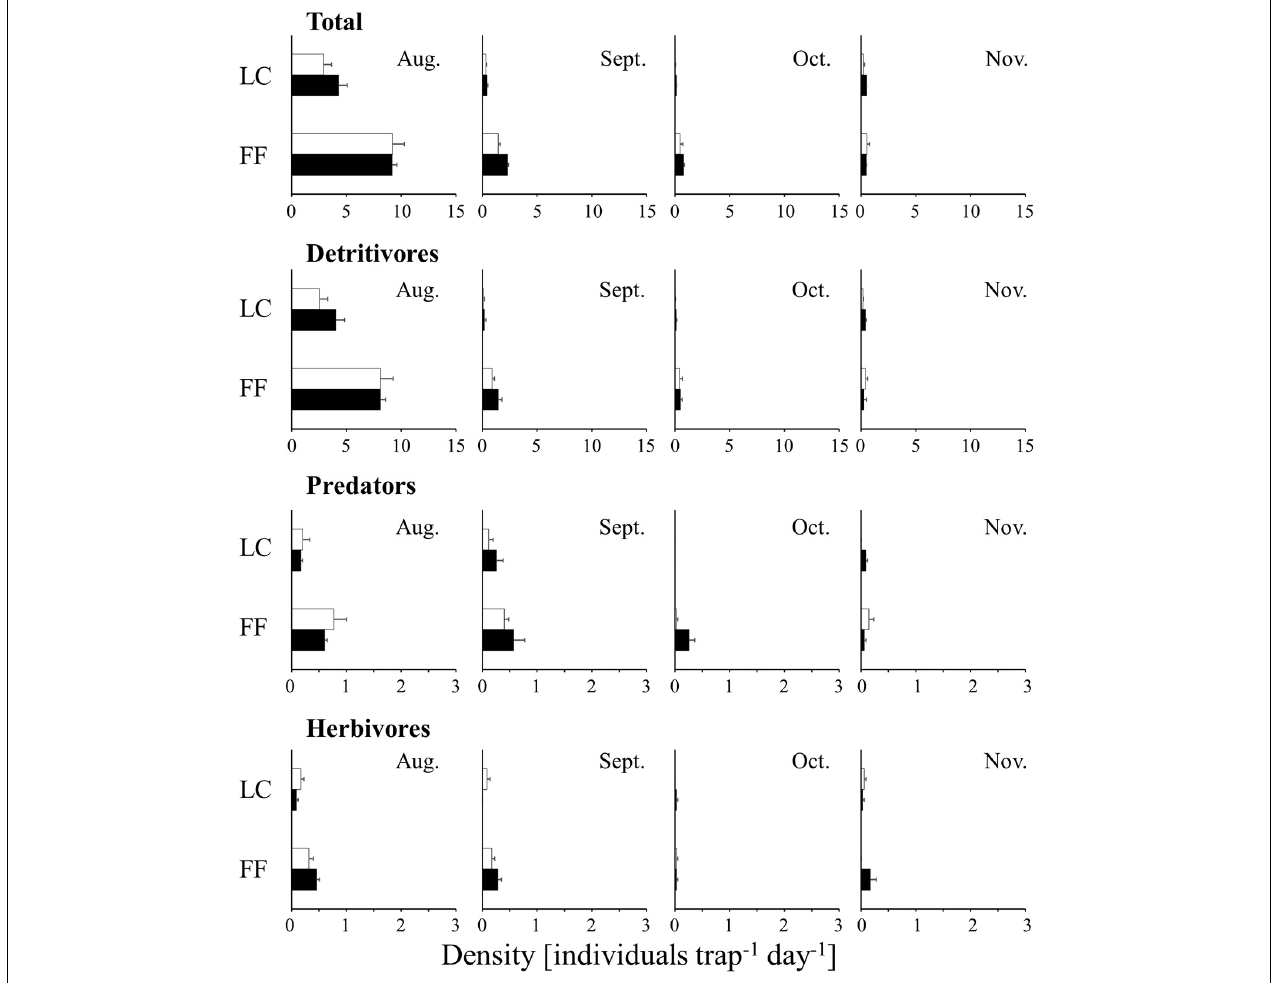
FIGURE 4 | Temporal changes in the density of flying arthropods collected by trunk-sticky traps in the vertical strata of a Japanese cedar ( Cryptomeria japonica ) forest. The black and white bars indicate upper and lower sticky bands, respectively. Values represent mean ± standard error. LC, lower canopy; FF, forest